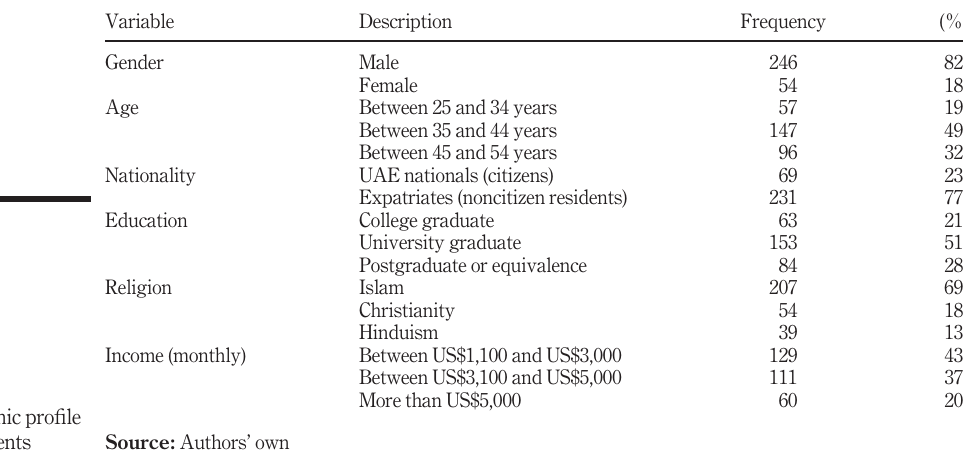
Table 5. Demographic pro fi